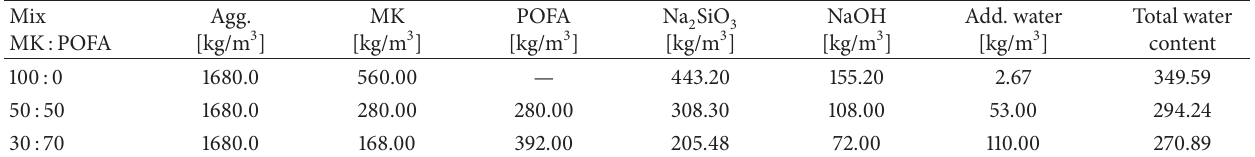
Table 2: Mix Design of Geopolymer